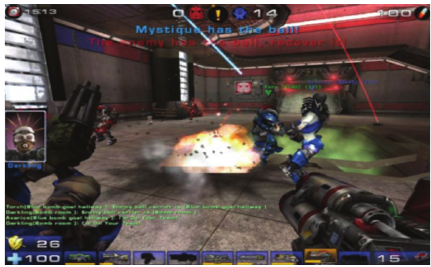
Figure 7: Screenshot of the UT game.